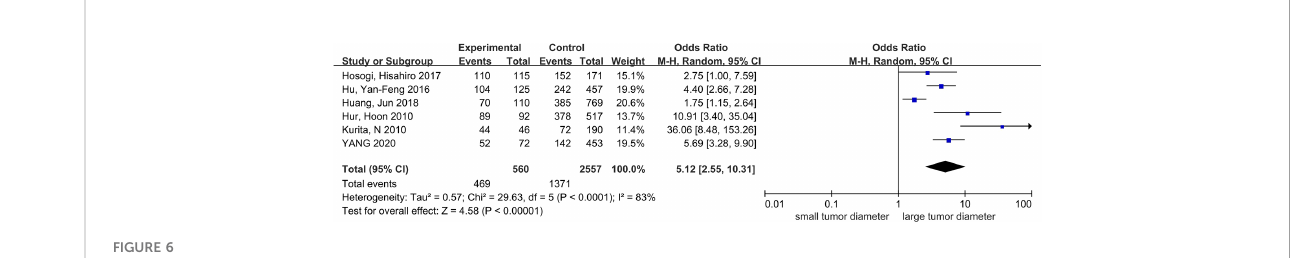
FIGURE 6 The correlation between tumor diameter and